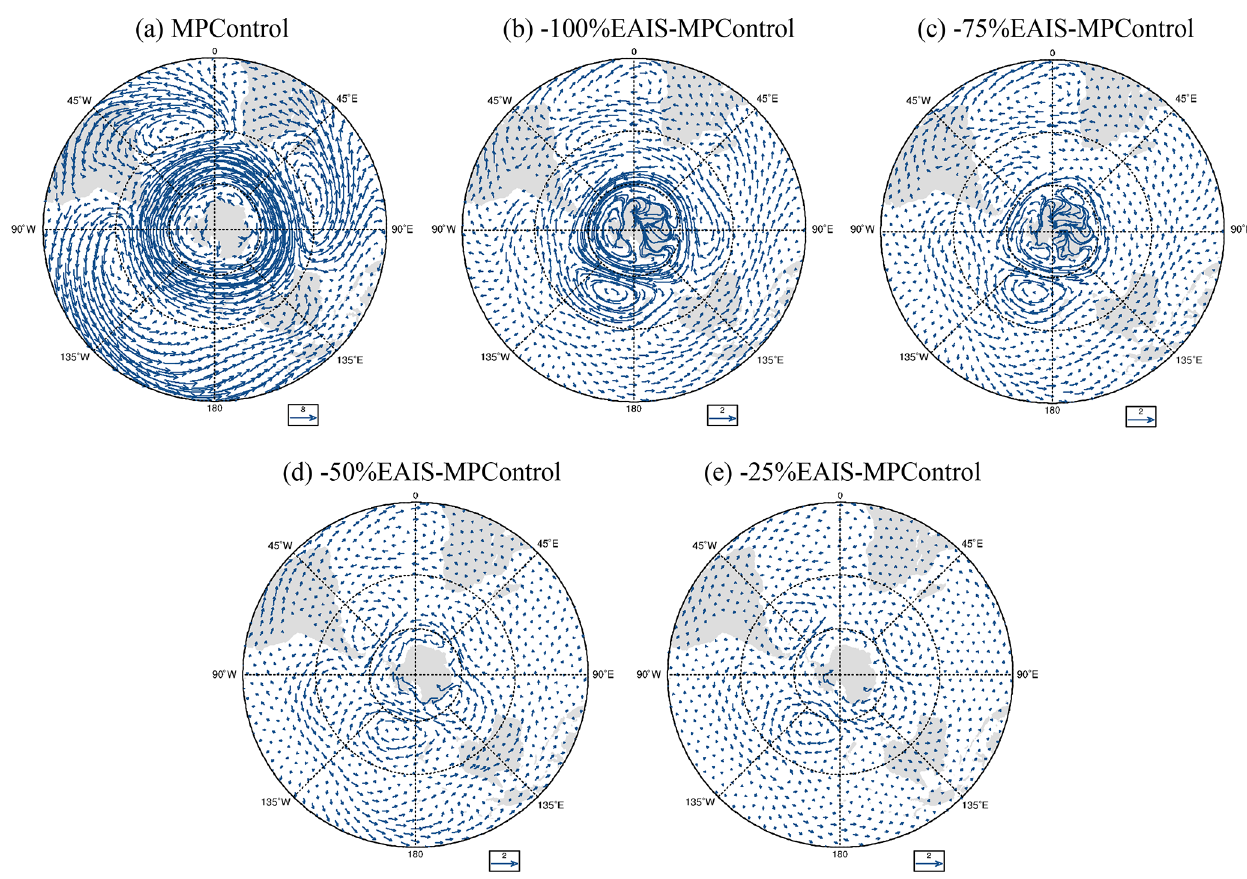
Figure 6. Annual mean wind circulation at 850hPa over the Southern Hemisphere (a ; units: ms − 1 ) and its corresponding anomalies in − 100%EAIS, − 75%EAIS, − 50%EAIS, and − 25%EAIS, respectively (b–e ; units: ms − 1 )